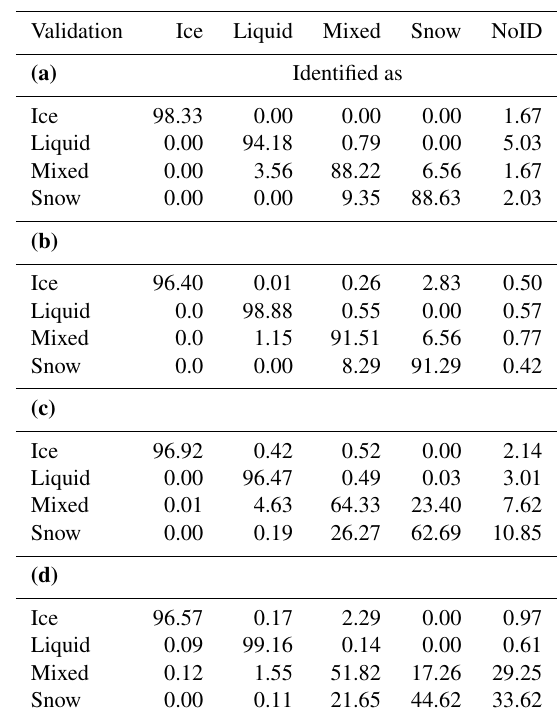
Table 3. Cross-validation results given in percentage of validation data in a given class. (a) 10 variable: complete testing data results. (27.9% of data). (b) 5 variable: complete data (52.2% of data). (c) 10 variable: the no lidar data results. (71.8% of the incomplete data). (d) 5 variable: no lidar data (92.7% of the incomplete data).